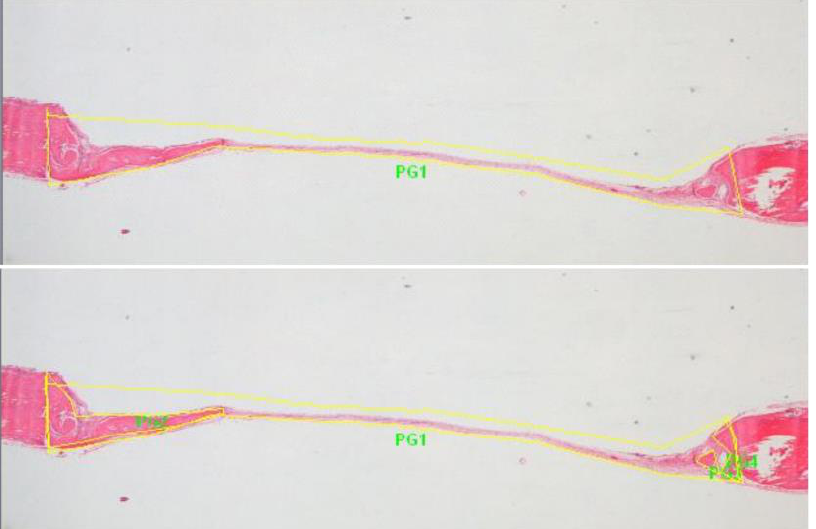
Figure 2. Pictures for histomorphometric measurements. PG1: total area (yellow) of bone defect, PG2, PG3 and PG4: areas of new bone formation within the total area of bone defect.